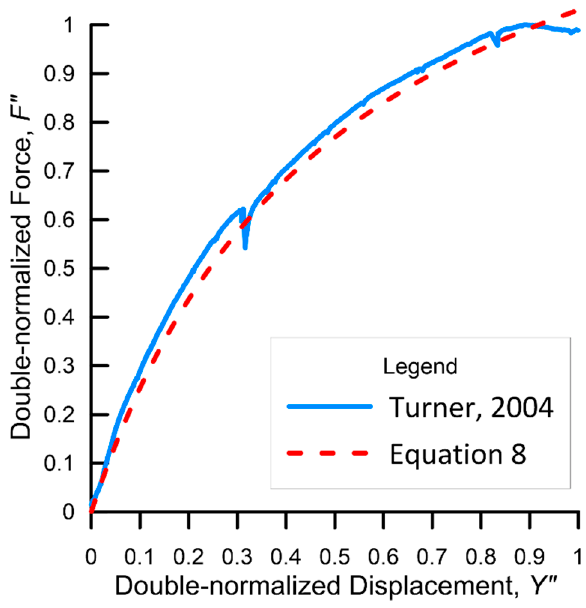
Figure 11. Validation of Figure 10 and Equation (8). Experiments performed by